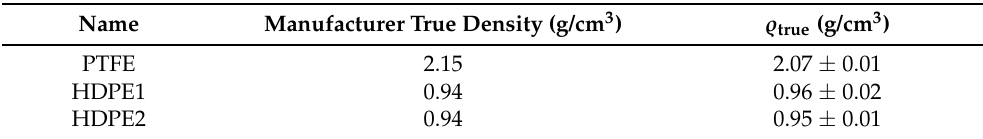
Table 2. Solid true density of PTFE and the two HDPE grades. Measured values are the mean ± one standard deviation ( n =